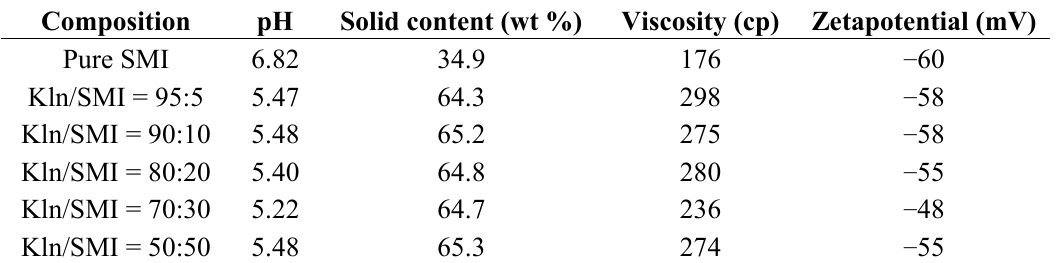
Table 2. Physical properties for aqueous dispersions of chemically reacted Kln/SMI. Composition pH Solid content (wt %) Viscosity (cp) Zetapotential